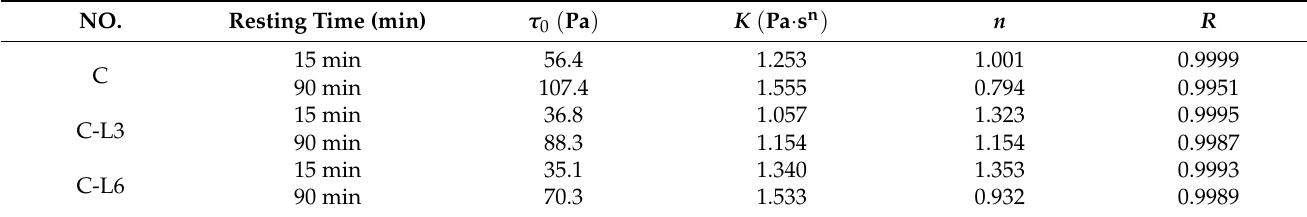
Table 6. Rheological parameters of C-LP pastes.